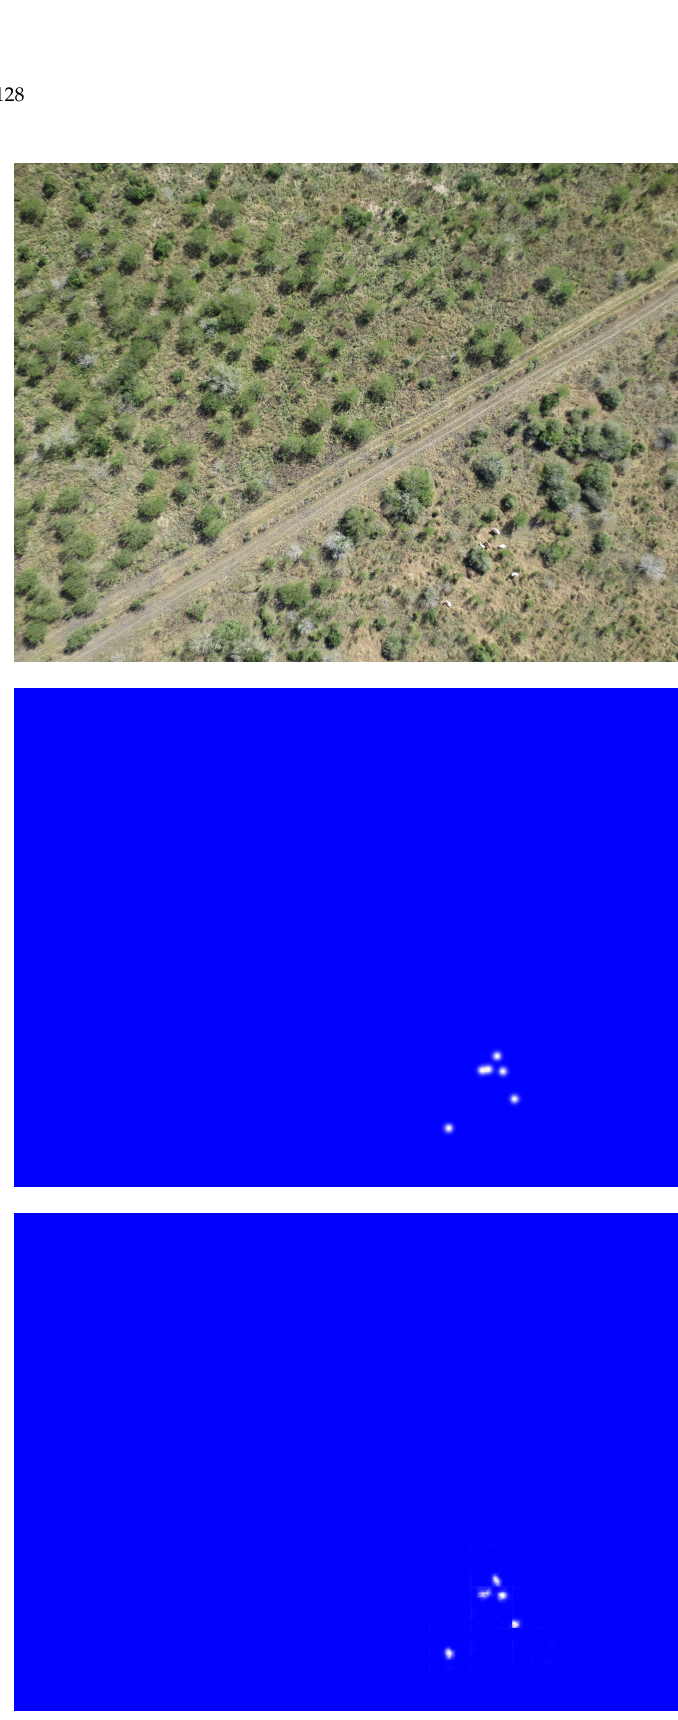
Figure 8. From top to bottom, a source image, its label, and our prediction heat